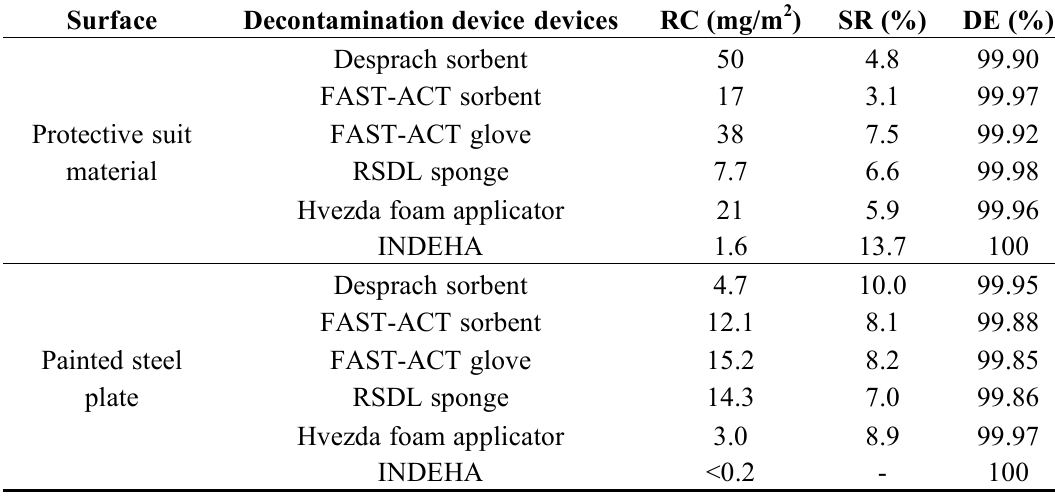
Table 4. Average values for residual surface contamination (RC), relative standard deviation (SR) and decontamination efficiency (DE) for acrylonitrile at an initial contamination level of 50 g/m 2 (permissible residual contamination 10 mg/m 2